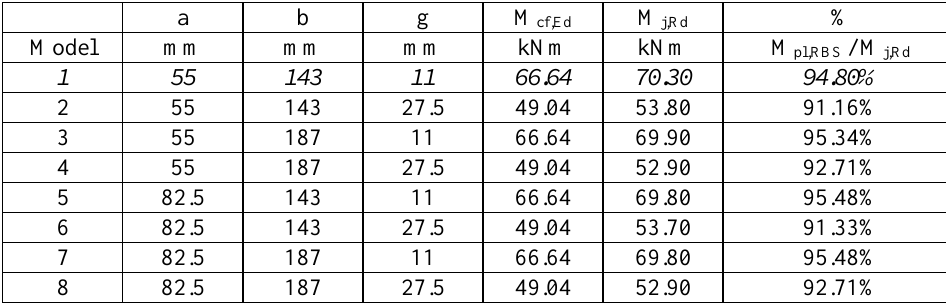
Results of stage 1